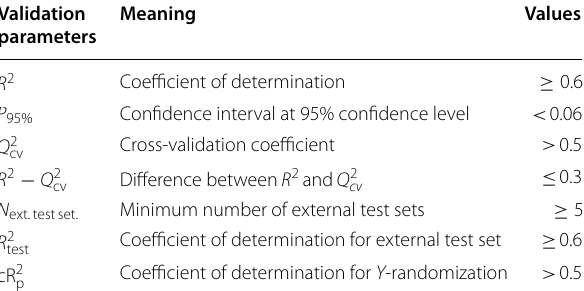
Table 2 Standard validation parameters for a good QSAR model Validation parameters